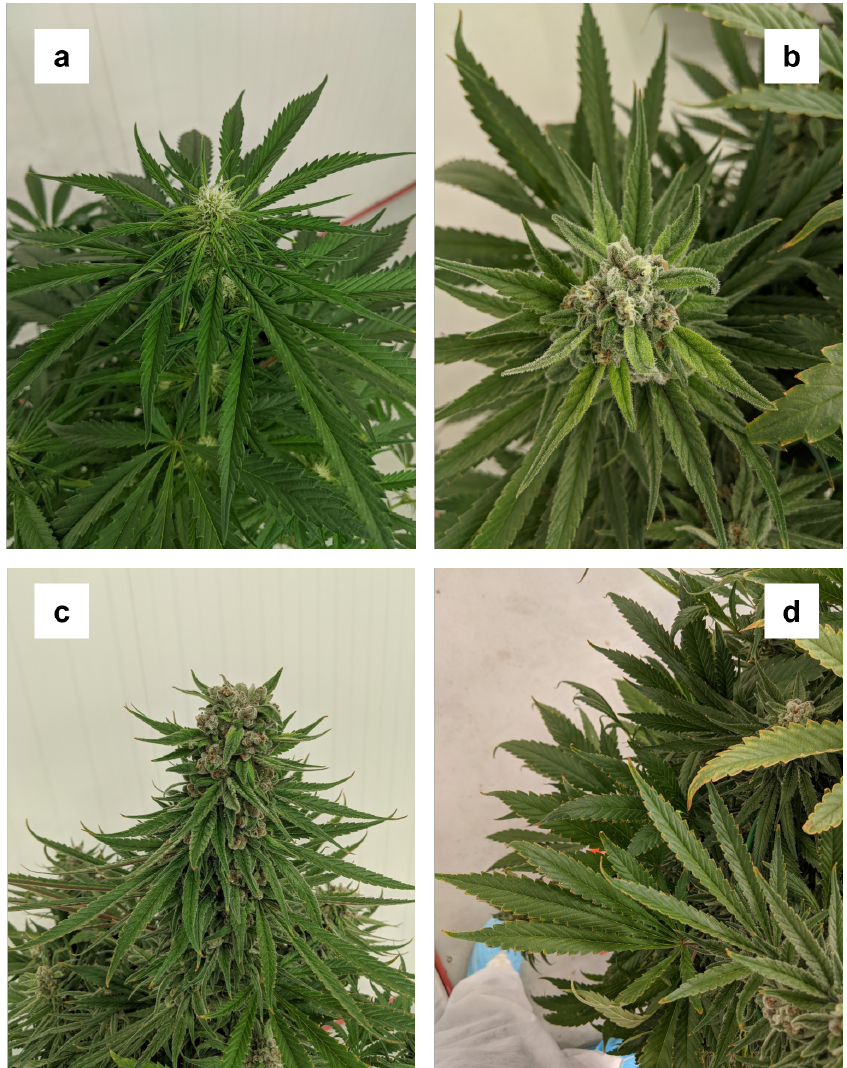
Figure 8. Progression of the various disparate symptoms iron deficiency on upper and lower canopy tissues throughout the trial: mild chlorosis on recently developed sugar leaves ( a ), mottling and chlorosis in the central areas of sugar leaves in week five ( b ), which disappeared in latter weeks ( c ), and edge necrosis on lower fan leaves in week six ( d